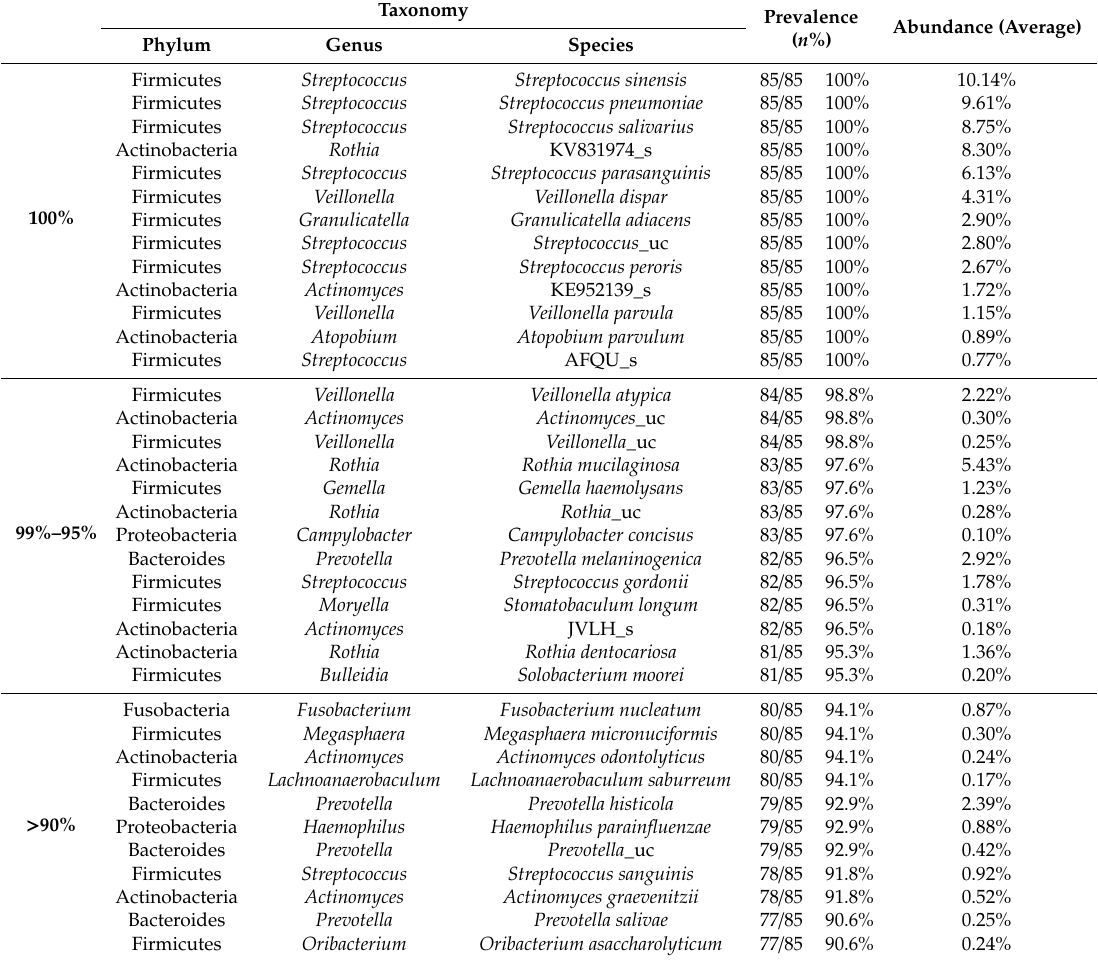
Table 1. Bacterial species detected in more than 90% of